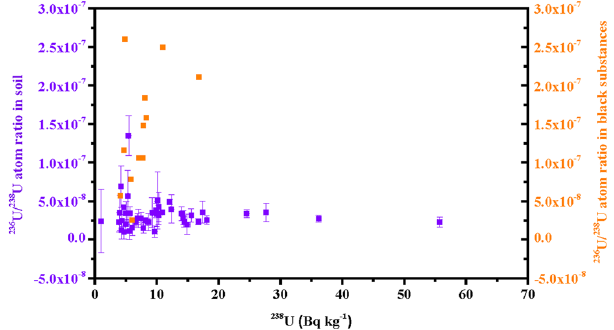
Figure 1. Plot showing the relationship between the 238 U activities and the 236 U/ 238 U atom ratio in soil samples collected in Fukushima Prefecture immediately after the FDNPP accident (left ordinate) and in black substances collected along roads in Fukushima Prefecture (right ordinate) 10 . Error bars on the soil sample values correspond to 1 σ